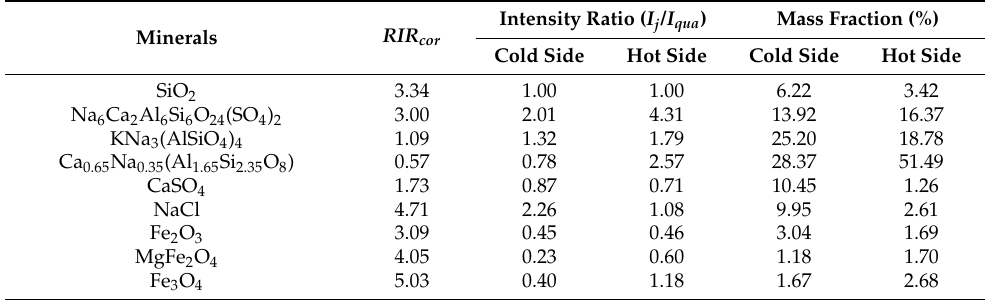
Table 2. Quantitative results of main minerals in the slagging samples collected from the exit flue of the second combustion